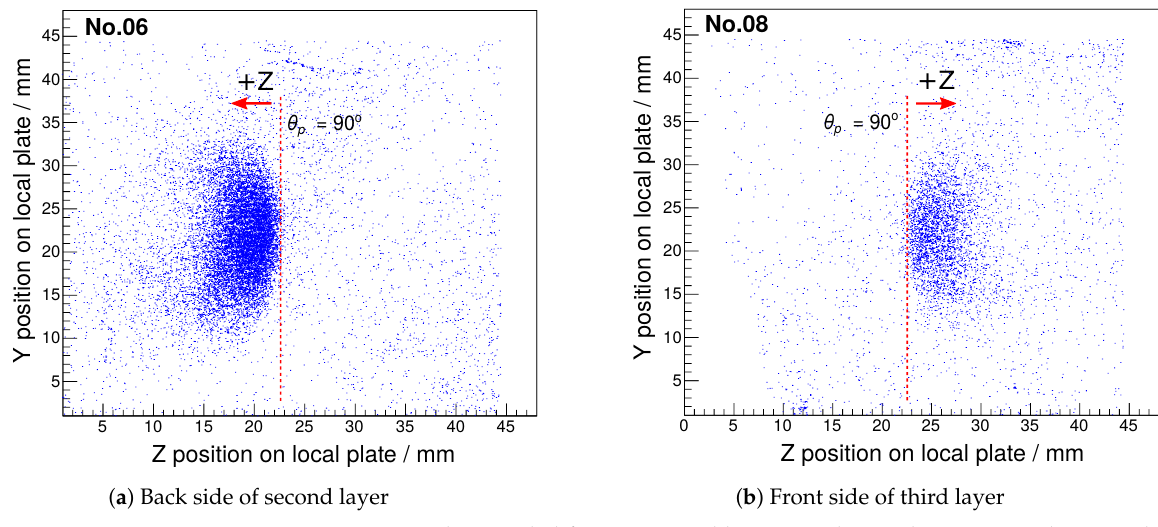
Figure 4. Proton tracks revealed from two neighbouring sides on the CR-39 stack. + Z is the 3 He beam direction. The red dashed lines indicate proton emission perpendicular to the beam